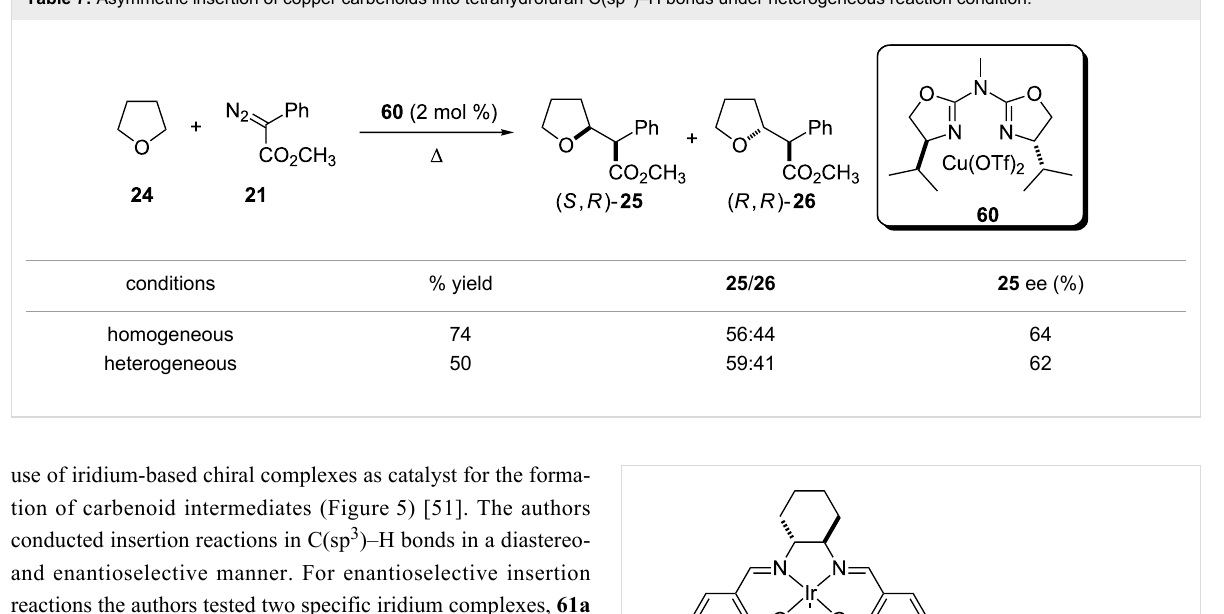
Table 7: Asymmetric insertion of copper carbenoids into tetrahydrofuran C(sp 3 )–H bonds under heterogeneous reaction condition.